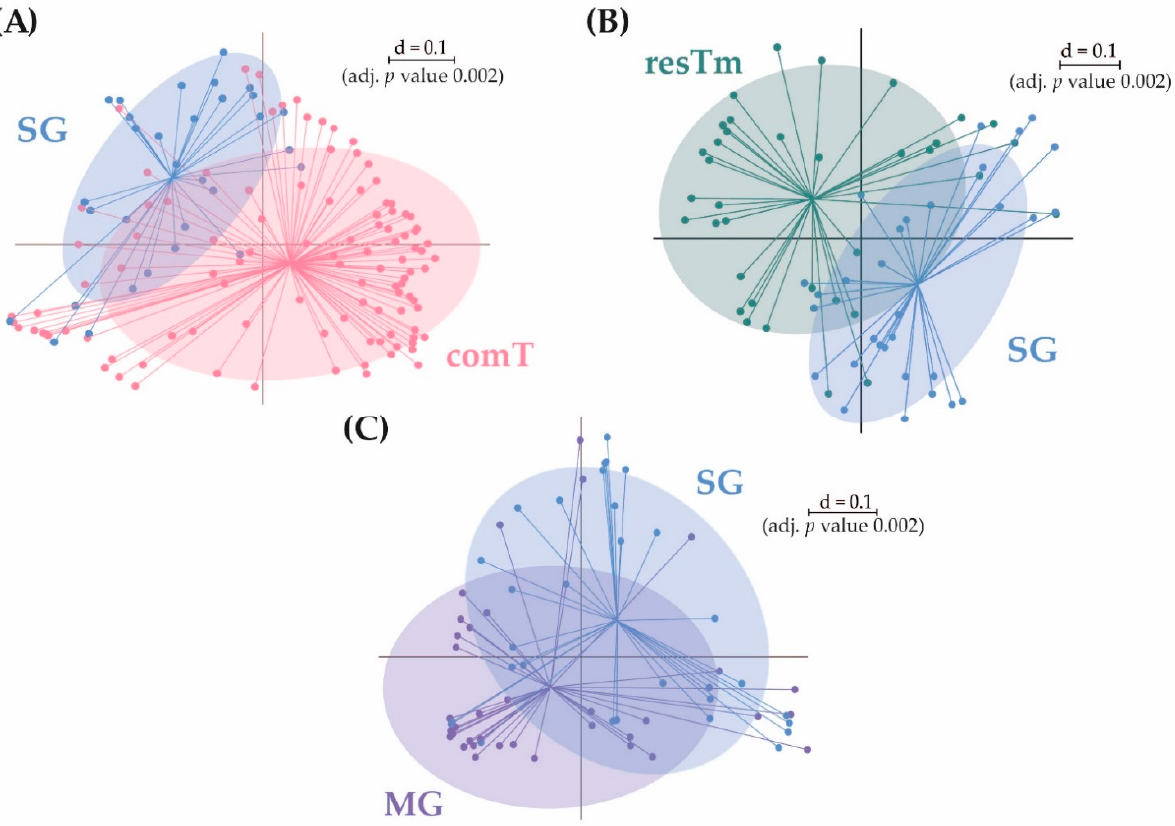
Figure 7 . Pairwise β -diversity of the groups ( A ) comT and SG, ( B ) resTm and SG as well as ( C ) MG and SG displayed as multidimensional-scaling (MDS) plot. The scale is an indicator for the differences in the phylogenetic makeup of microbiota between samples ( β -diversity) based on general UniFrac distances (d = 0.1, 10% difference). comT, complete Ixodes ricinus tick; resTm, residual tick material; MG, midgut; SG, salivary gland.